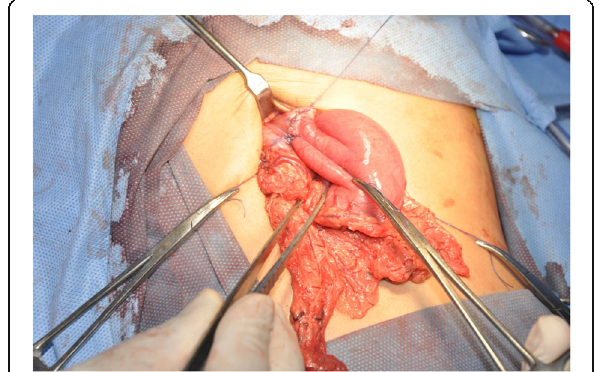
Fig. 5 The longitudinal incision was closed transversely by one layer interrupted